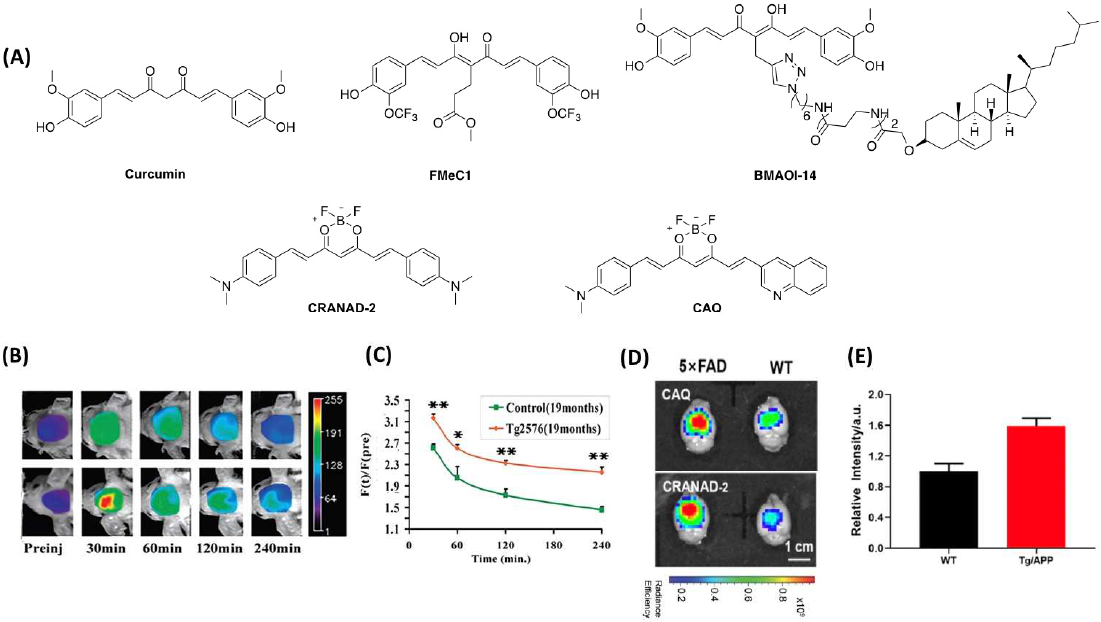
Figure 2. ( A ) The structures of curcumin, FMeC1, BMAOI − 14, CRANAD − 2 and CAQ; ( B ) Representative images of Tg2576 mice and control mice at different time points; ( C ) The fluorescence signal curves of F(t)/F(pre) between transgenic mice and the control group (* p < 0.05, ** p < 0.01); Reprinted with permission from [50]. Copyright 2009 American Chemical Society. ( D ) Representative images of 5XFAD mice and WT mice at 30 min. ( E ) Fluorescence intensity of the brain in 5XFAD and WT mice at 30 min. Reprinted with permission from [51]. Copyright 2021 American Chemical Society.